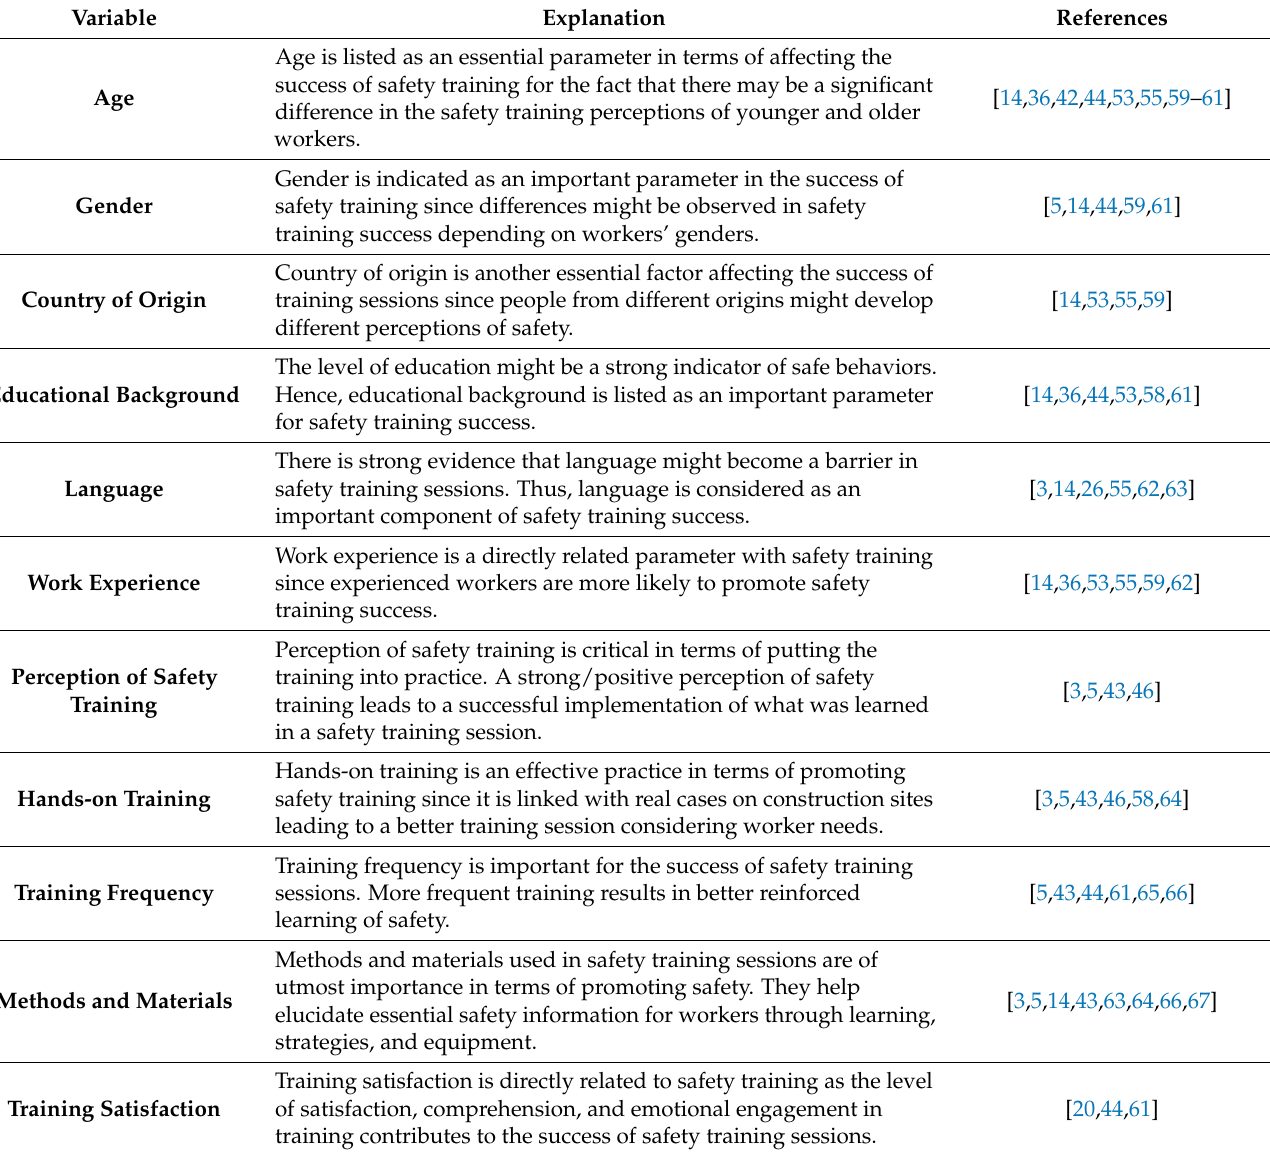
Table 1. Safety training success